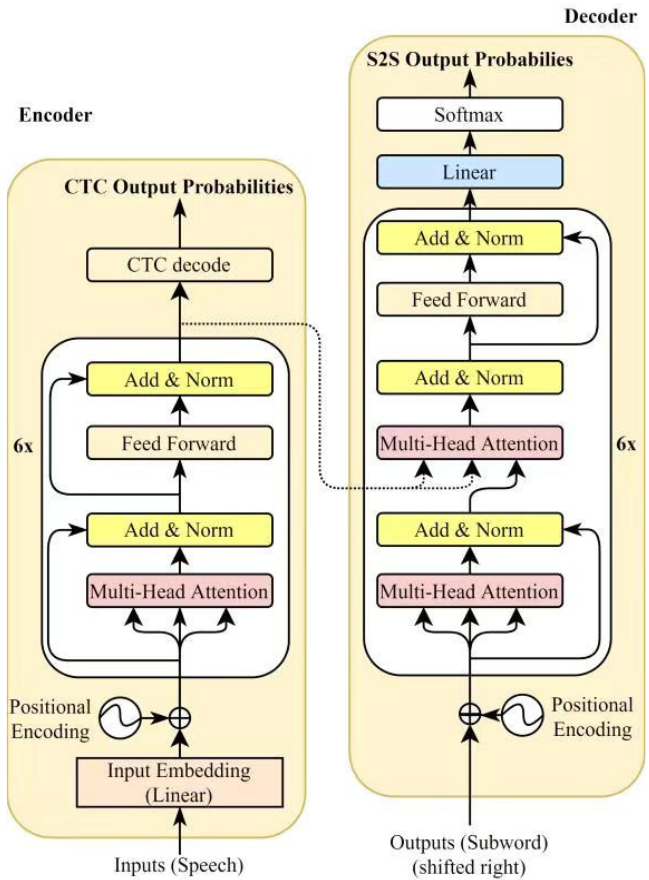
Figure 5. Transformer-based E2E ASR model jointly trained with CTC loss.